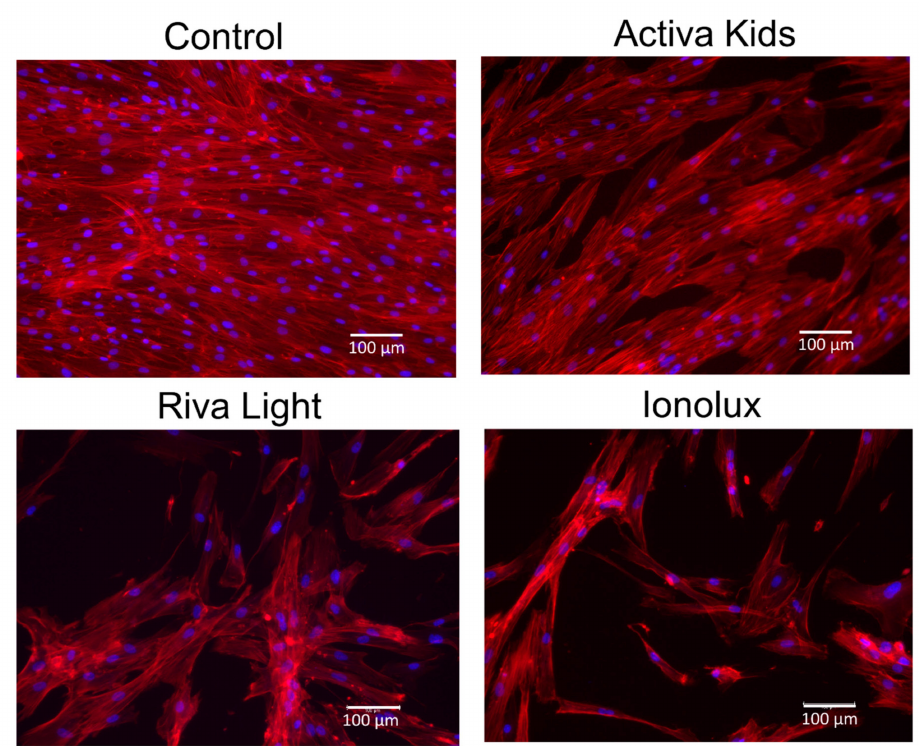
Figure 4. Changes in the cell morphology of hDPSCs exposed to the undiluted extracts of Activa, Ionolux, and Riva. Cytoskeleton (Phalloidin, red) and nucleus (DAPI, blue) immunostainings of hDPSCs at Day 3. The scale bar represents 100 µ m for all images.